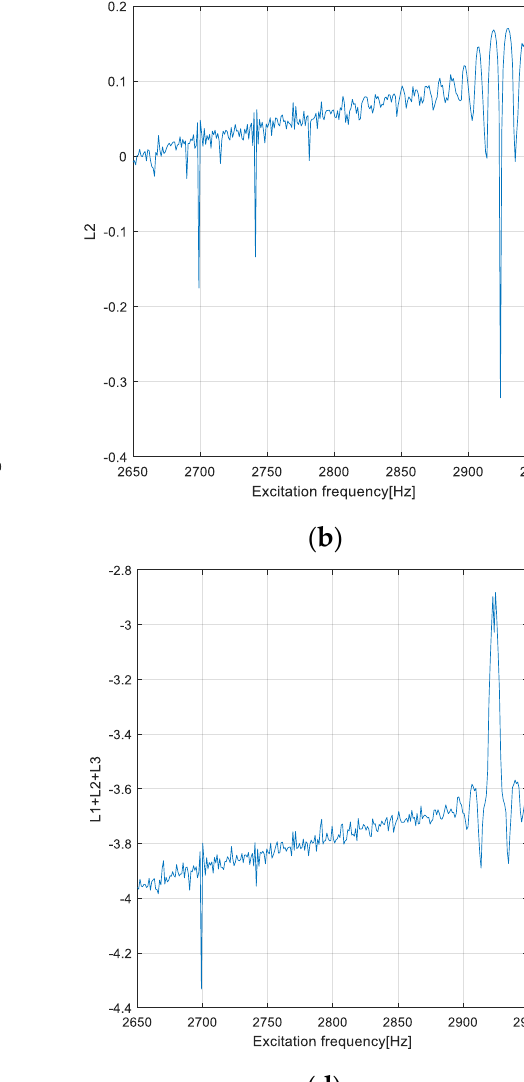
instabilities in a Hooke’s joint-driven system via maximal Lyapunov’s exponents (the well- Figure 23. Lyapunov exponents of NFTV for DOE3, 0 9  = , 3 10.4 10 −  =  . known MLEM). They found a direct link between the maximal Lyapunov exponents and 2 the instability regions for subharmonic and combination resonances.